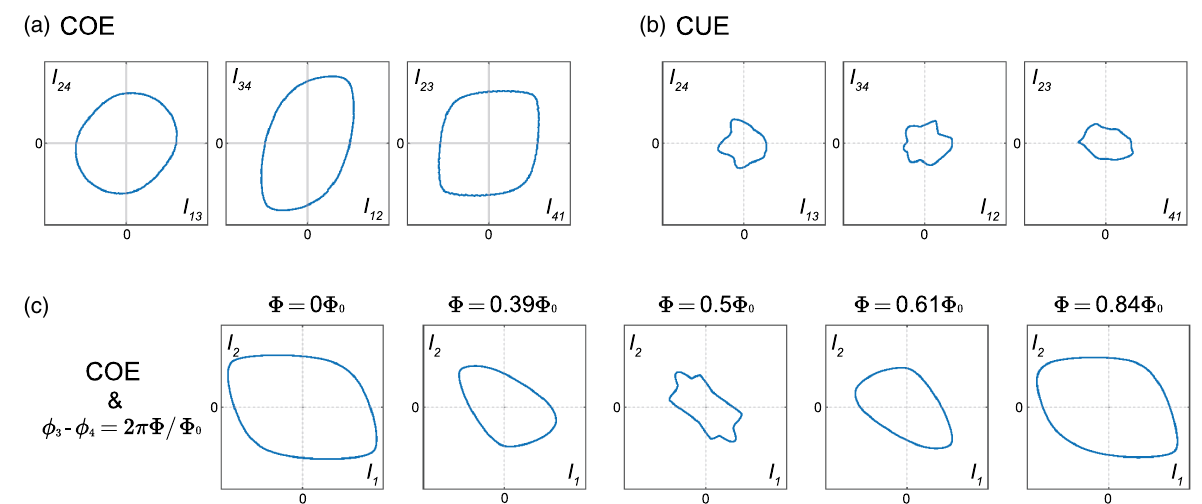
ˆ S matrix. Note